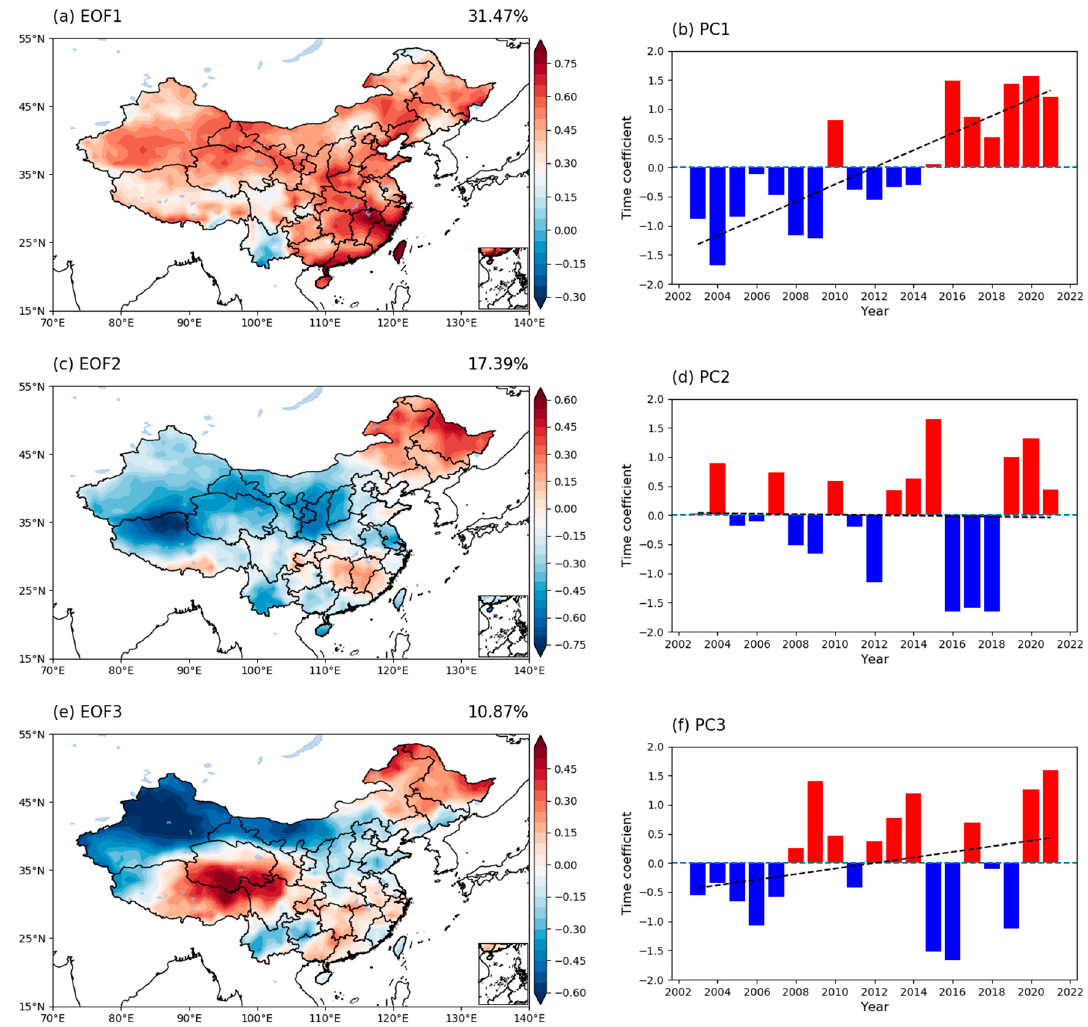
Figure 3. ( a , c , e ) Spatial distribution of EOF of the TCWV, and ( b , d , f ) corresponding normalized principle component (PC). principle component